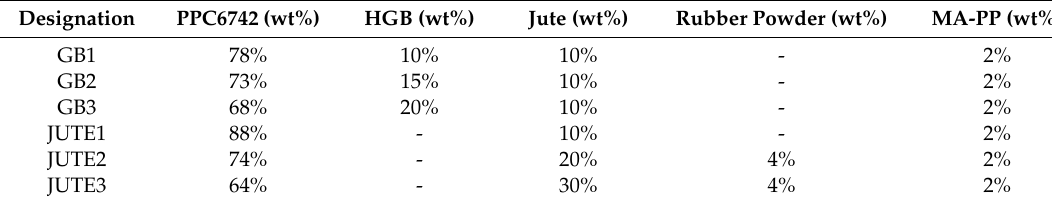
Table 2. Material formulations used in this